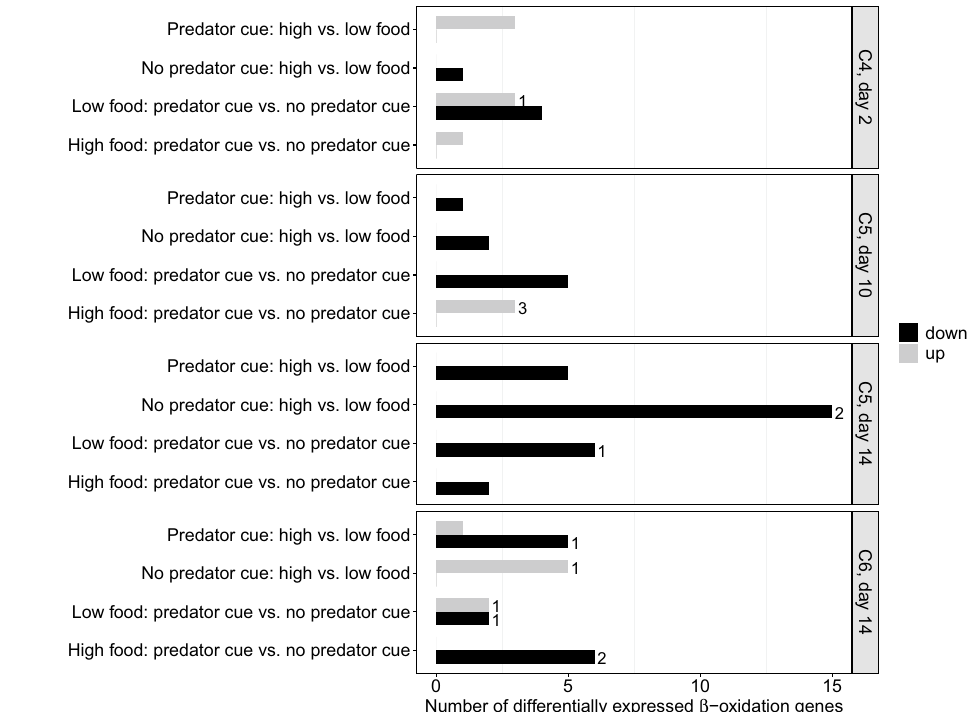
Figure 4. Number of significant (P < 0.05) differentially expressed ß-oxidation genes (x-axis) between experimental treatments (y-axis, left) in Calanus finmarchicus copepods exposed to a combination of presence or absence of a predator cue with high or low food availability. Numbers next to bars indicate numbers of genes encoding FA ligases (rate-limiting step). Comparisons of treatments were done separately per sampling day (2, 10 and 14) and stage (C4, C5 and C6, y-axis, right). The first treatment within each comparison is set as reference to the second treatment, e.g. 4 genes upregulated in “Predator cue: high vs. low food” = 4 genes up in predator cue + high food and the same 4 genes down in predator cue + low